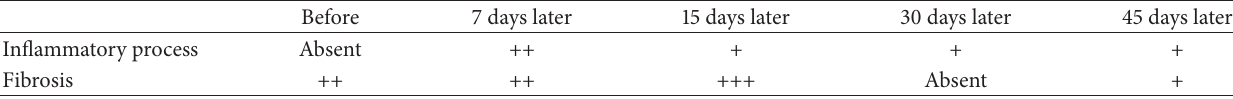
Table 3: Description of the sonography results regarding the inflammatory process and fibrosis presence.